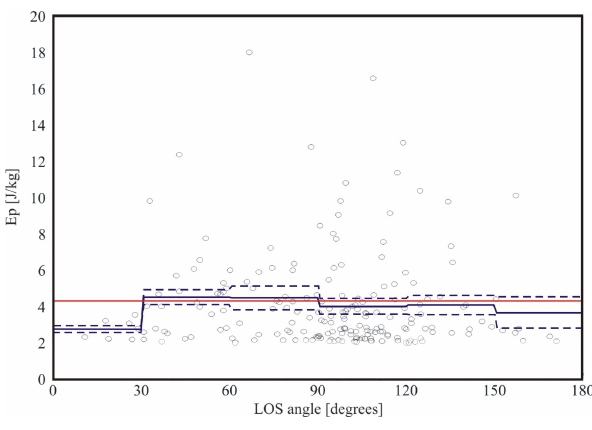
Fig. 7. E p against LOS angle for all the studied cases. Solid lines represent the average E p in every 30 ◦ interval after removal of events below the 2J/kg threshold. The vertical interval correspond- ing to the standard deviation of the mean in each bin is represented by the dashed lines and the total average E p (after removal of the 2J/kg threshold) is given by the red